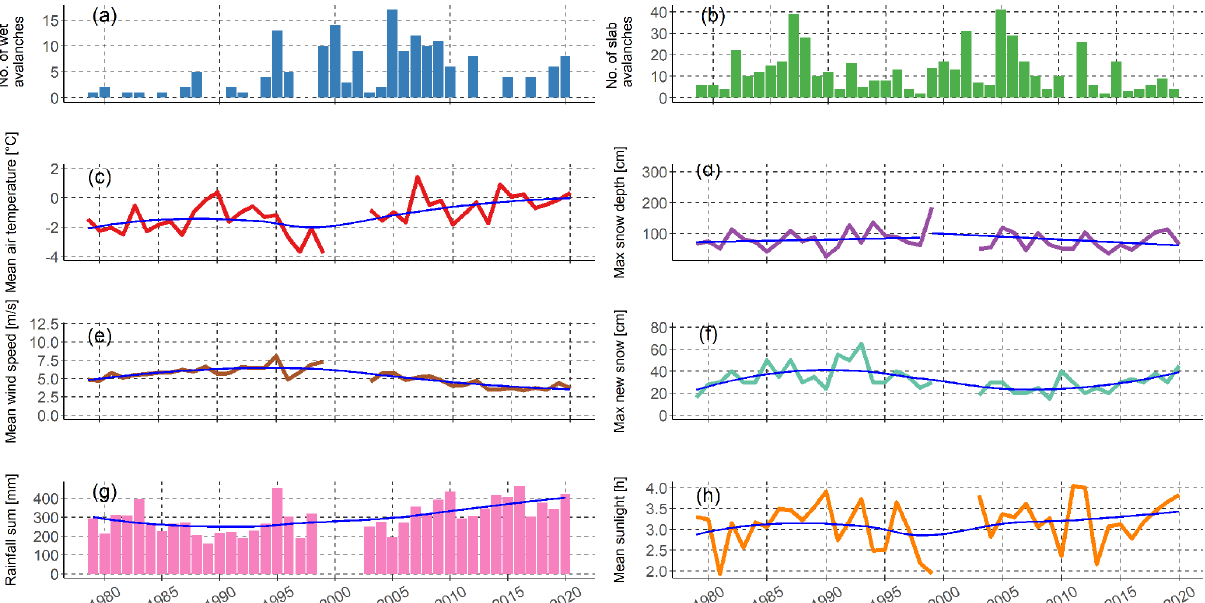
Figure 12. Avalanche occurrence distribution and meteorological and snow variable conditions at the Labská bouda automated weather station (1320ma . s . l . ) from 1979 to 2020. Horizontal axes represents winter season daily data aggregation from 1 October to 31 May. The time series includes a data gap from winter seasons 1999–2002 for all weather variables. Blue line shows local polynomial regression for two compared periods (1979–1998, 2003–2020). Air temperature, wind speed, and sunlight subplots represent mean daily values over the given winter